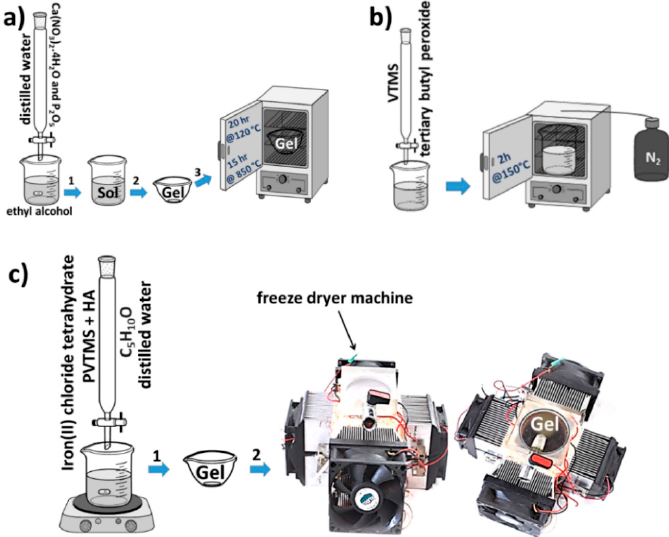
Figure 3. ( a ) Synthesis route of HA, ( b ) polymerization route of VTMS and ( c ) fabrication route of the HA/PVTMS/Cl 2 FeH 8 O 4 Composite.